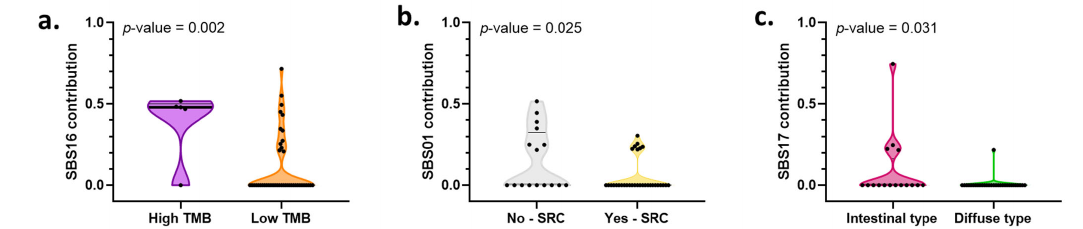
Figure 5. Mutational processes associated with clinical–pathological characteristics of patients with gastric adenocarcinoma treated at The Instituto Nacional de Cancerología between January 2019 and January 2020 (n = 49). ( a ) Violin plot depicting the association between the contribution of single ‐ base substitution signature (SBS) 16 and the tumoral mutational burden (TMB) status of the patients. ( b ) Violin plot depicting the association between the contribution of SBS01 and the presence of signet ‐ ring cells (SRSs). ( c ) Violin plot depicting the association between the contribution of SBS17 and the tumor histology.